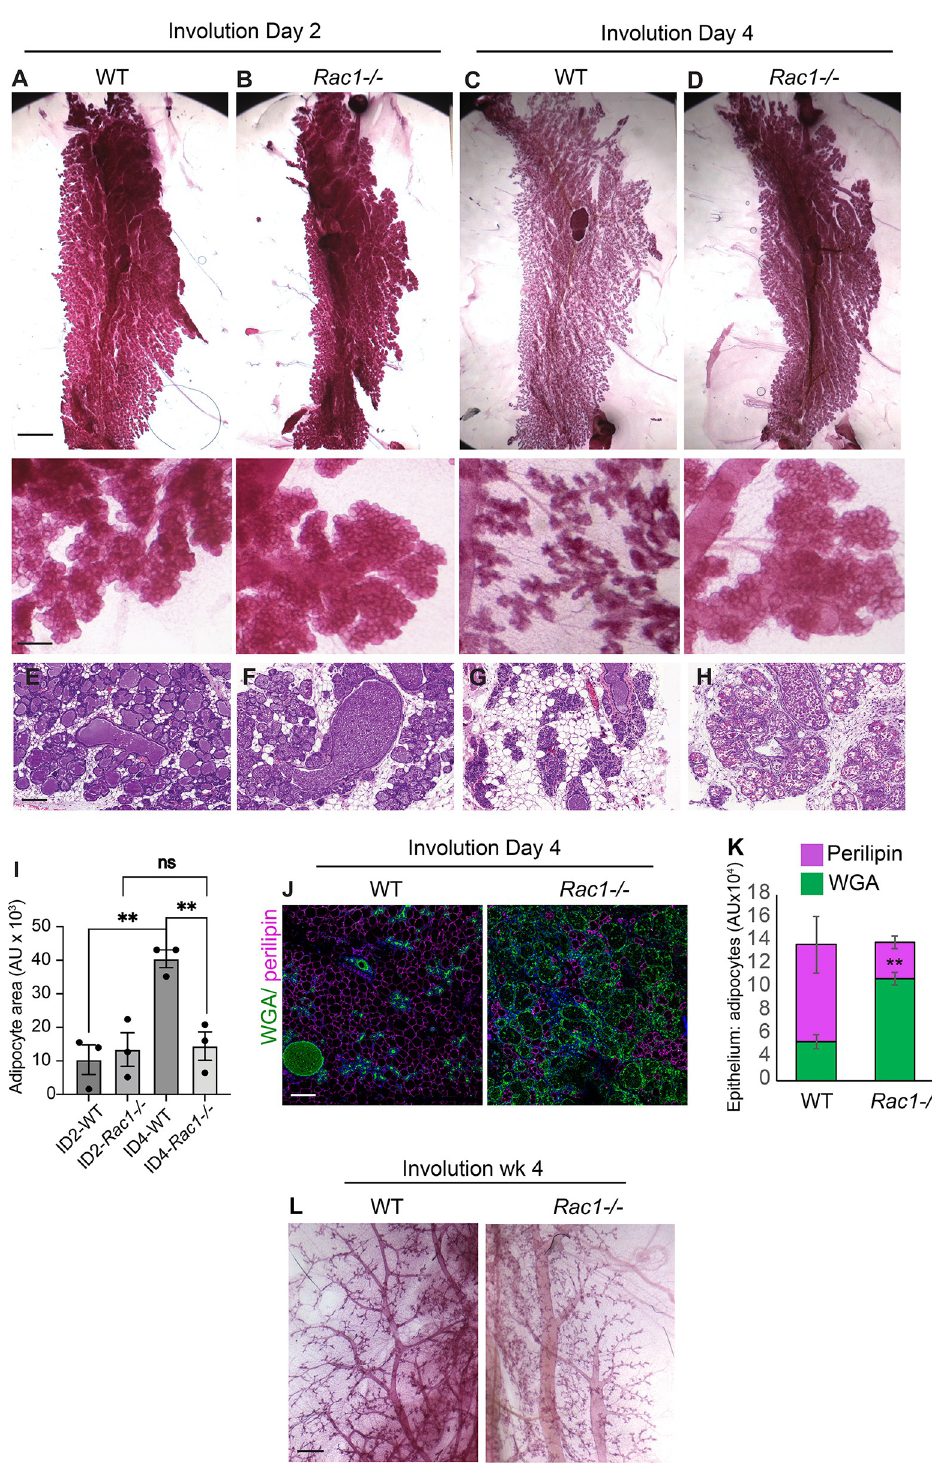
Fig 1. Delayed alveolar regression in Rac1−/− glands in involution. ( A - D ) Carmine staining of whole-mounted mammary glands of WT ( A , C ) and Rac1−/− ( B , D ) mice at postlactational involution day 2 and day 4. Note the alveolar regression in WT but not Rac1−/− glands at involution day 4. Bar: 5 mm, (inset 1 mm). ( E - H ) Haematoxylin– eosin (HE) stain shows alveolar regression and adipocyte repopulation in WT glands ( E , G ), but this is delayed in Rac1−/− glands ( F , H ). Bar: 100 μ m. ( I ) Quantification of adipocyte repopulation in HE images. Error bars: +/ − SEM